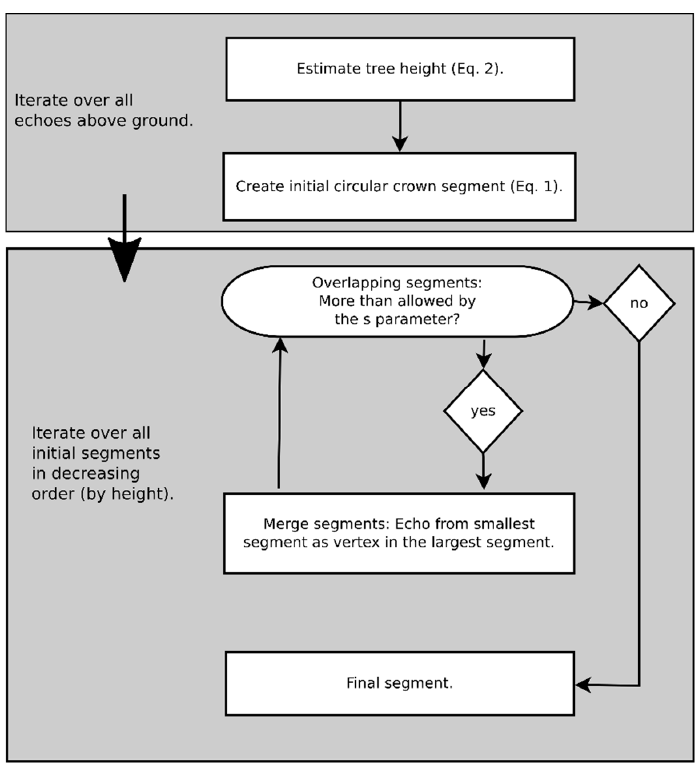
Figure 4. Flow diagram showing an outline of the segmentation process.